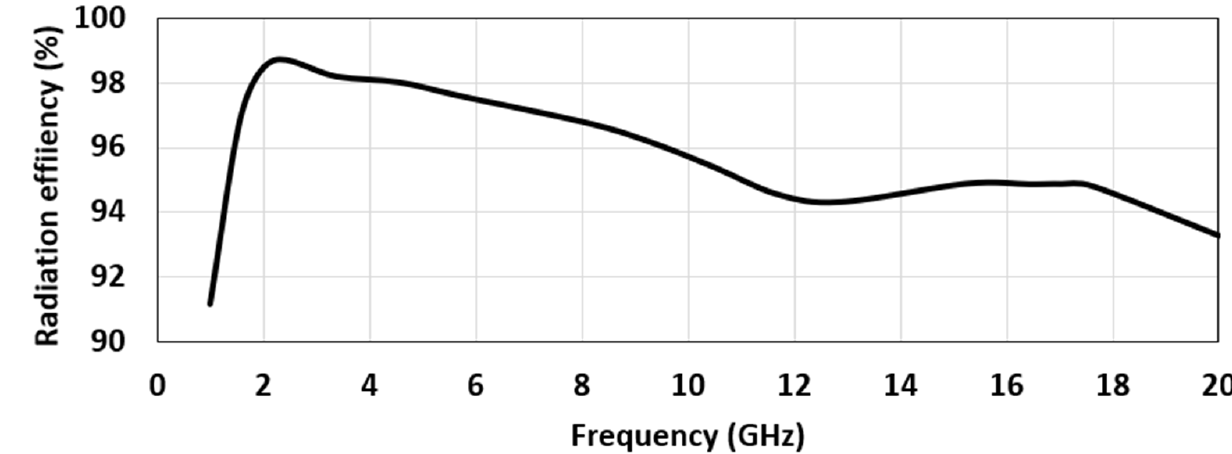
Figure 8. The simulated radiation efficiency plot as a function of frequency.